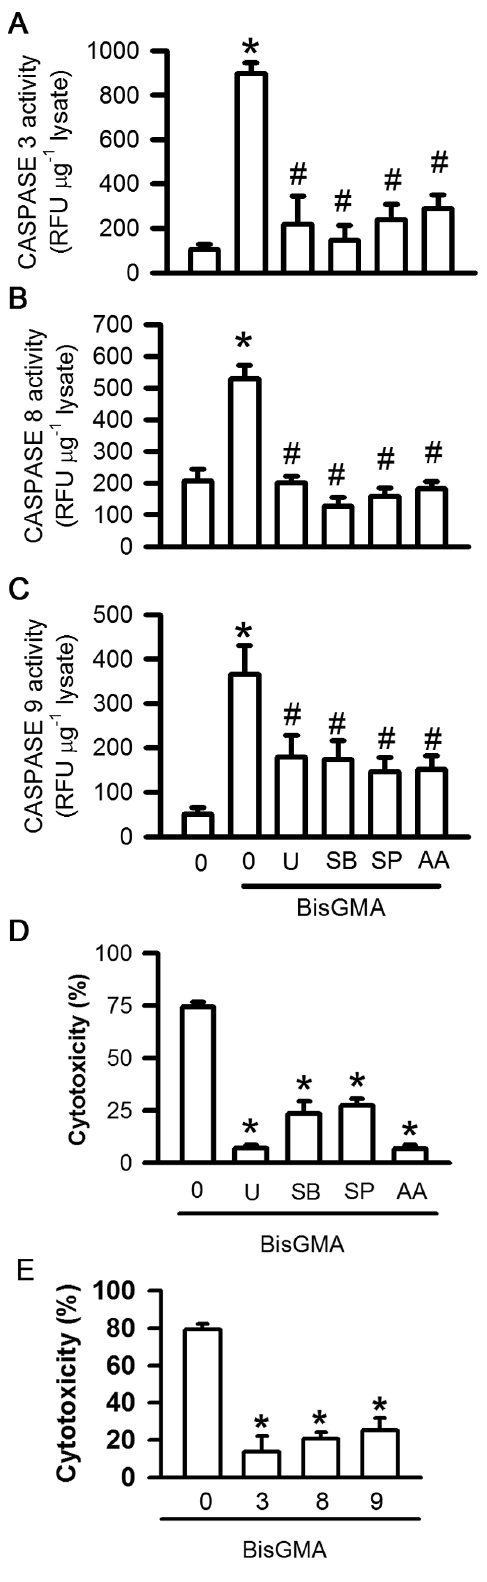
Figure 9. Effects of U0126, SB203580, SP600125, and AA- COCF3 on BisGMA-induced caspases activation and cytotoxic- ity. After treatment with 1 m M U0126, 30 m M SB203580, 30 m M SP600125, and 30 m M AACOCF3 for 30 min, RAW264.7 macrophages